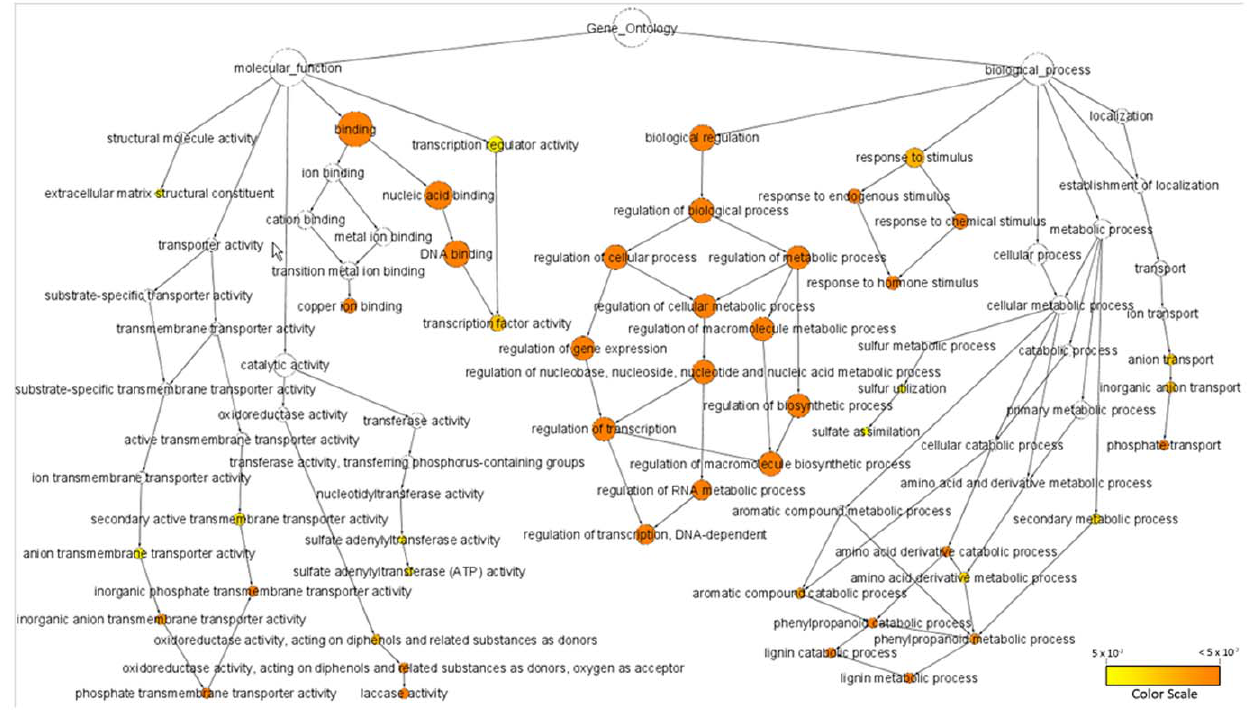
Figure 5. Maize miRNA targets enrichment network based on GO molecular functions and biological processes. Significantly overrepresented GO terms based on GO molecular functions and biological processes were visualized in Cytoscape. The size of a node is proportional to the number of targets in the GO category. The color represents enrichment significance— the deeper the color on a color scale, the higher the enrichment significance. White color nodes are not enriched but show the hierarchical relationship among the enriched ontology branches.